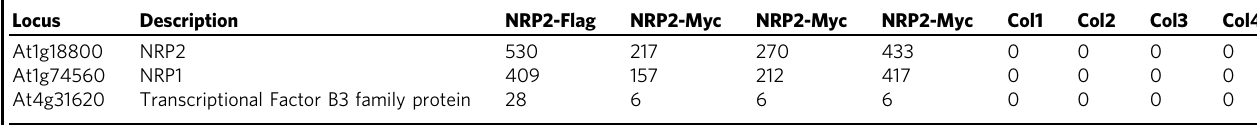
Table 1 Mass spectrometric analyses of NRP2-3xFlag and NRP2-9xMyc af fi nity puri fi cations. Locus